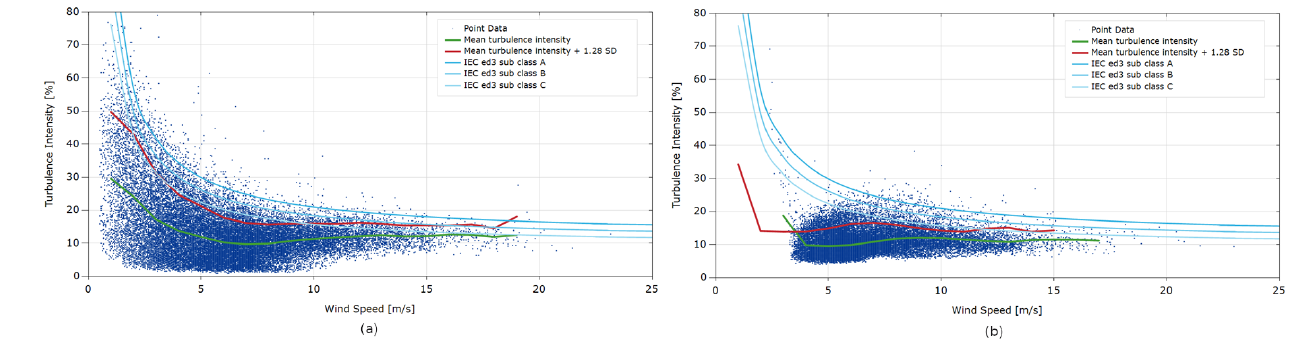
Figure 7. Turbulence intensity (%) measured by (a) Windcube v2 at 80m and (b) turbine SMV6 vs. wind speed (ms − 1 ).